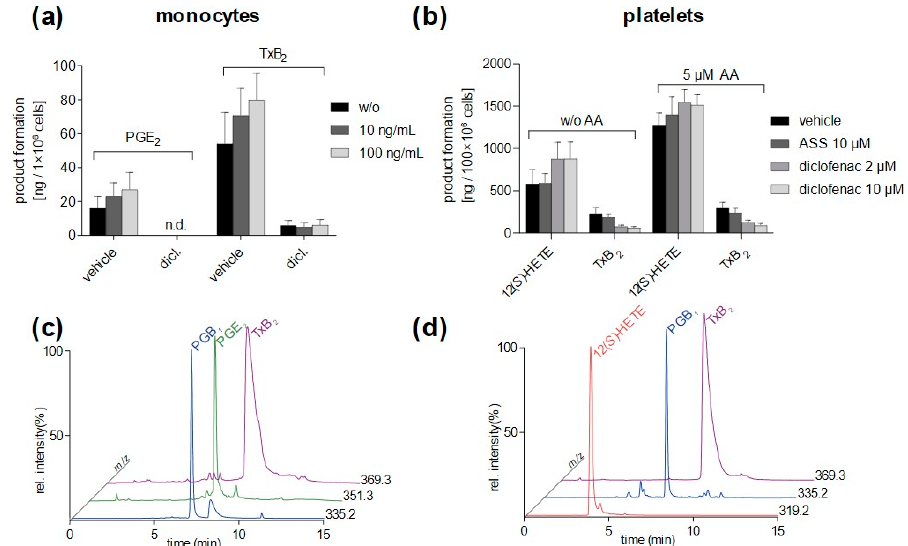
Figure 6. ( a ) TxB 2 and PGE 2 formation in monocytes generated by LPS stimulation (10 and 100 ng/mL). Eicosanoid biosynthesis was inhibited by pretreatment with diclofenac (2 µM). ( b ) Platelets were resuspended in PGC buffer, preincubated by COX inhibitors ASS (10 µM) or diclofenac (2 and 10 µM), and 12( S )-HETE and TxB 2 formation in platelets was initiated by 2.5 µM A23187 ± 5 µM AA. Samples were diluted at 1:10 to stay within the validated range. While COX-derived TxB 2 formation was inhibited, 12( S )-HETE was formed by 12-LOX independent of COX inhibitors. Values are expressed as mean + SEM ( n = 3). ( c , d ) Representative SIM chromatograms are shown for PGE 2 and TxB 2 formation in monocytes ( c ) and 12( S )-HETE and TxB2 in platelets ( d ). PGB 1 was added exogenously as an internal standard.